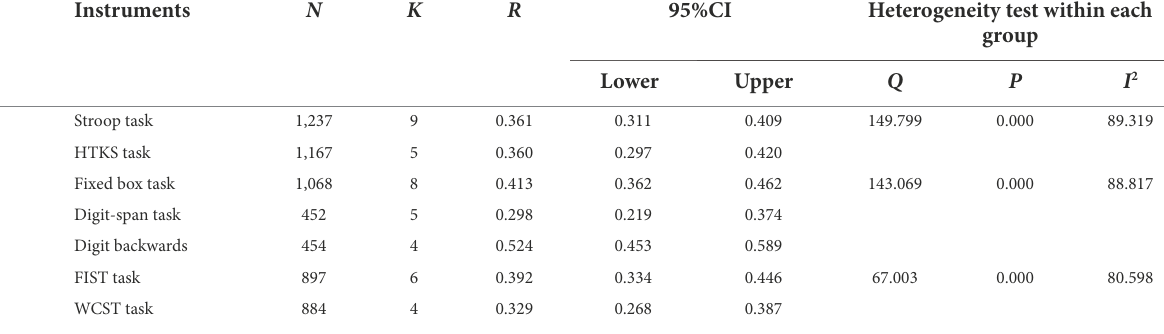
TABLE 5 The moderating effect of instruments on executive functions and mathematical competence in preschool children.